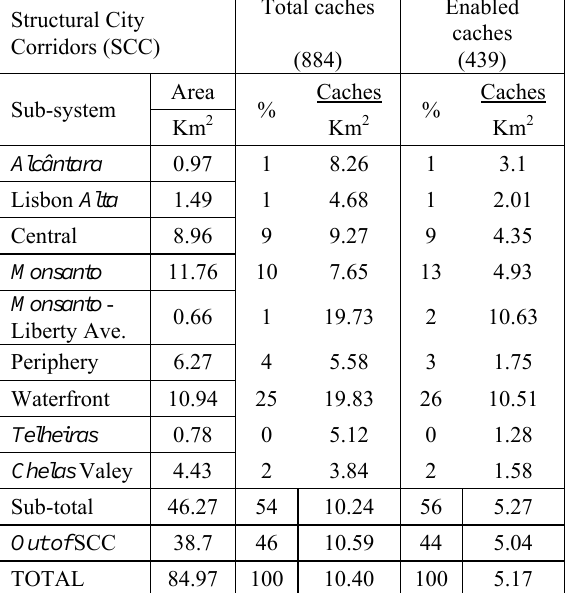
Figure 3. Lisbon Geocaching Activity from 2001 to 2012 regarding the cumulative number of total caches hidden and Enabled caches per year. Cache Logs Rate (C LogR ) and Cache Visitation Rate (C vR ) shown represent average values.